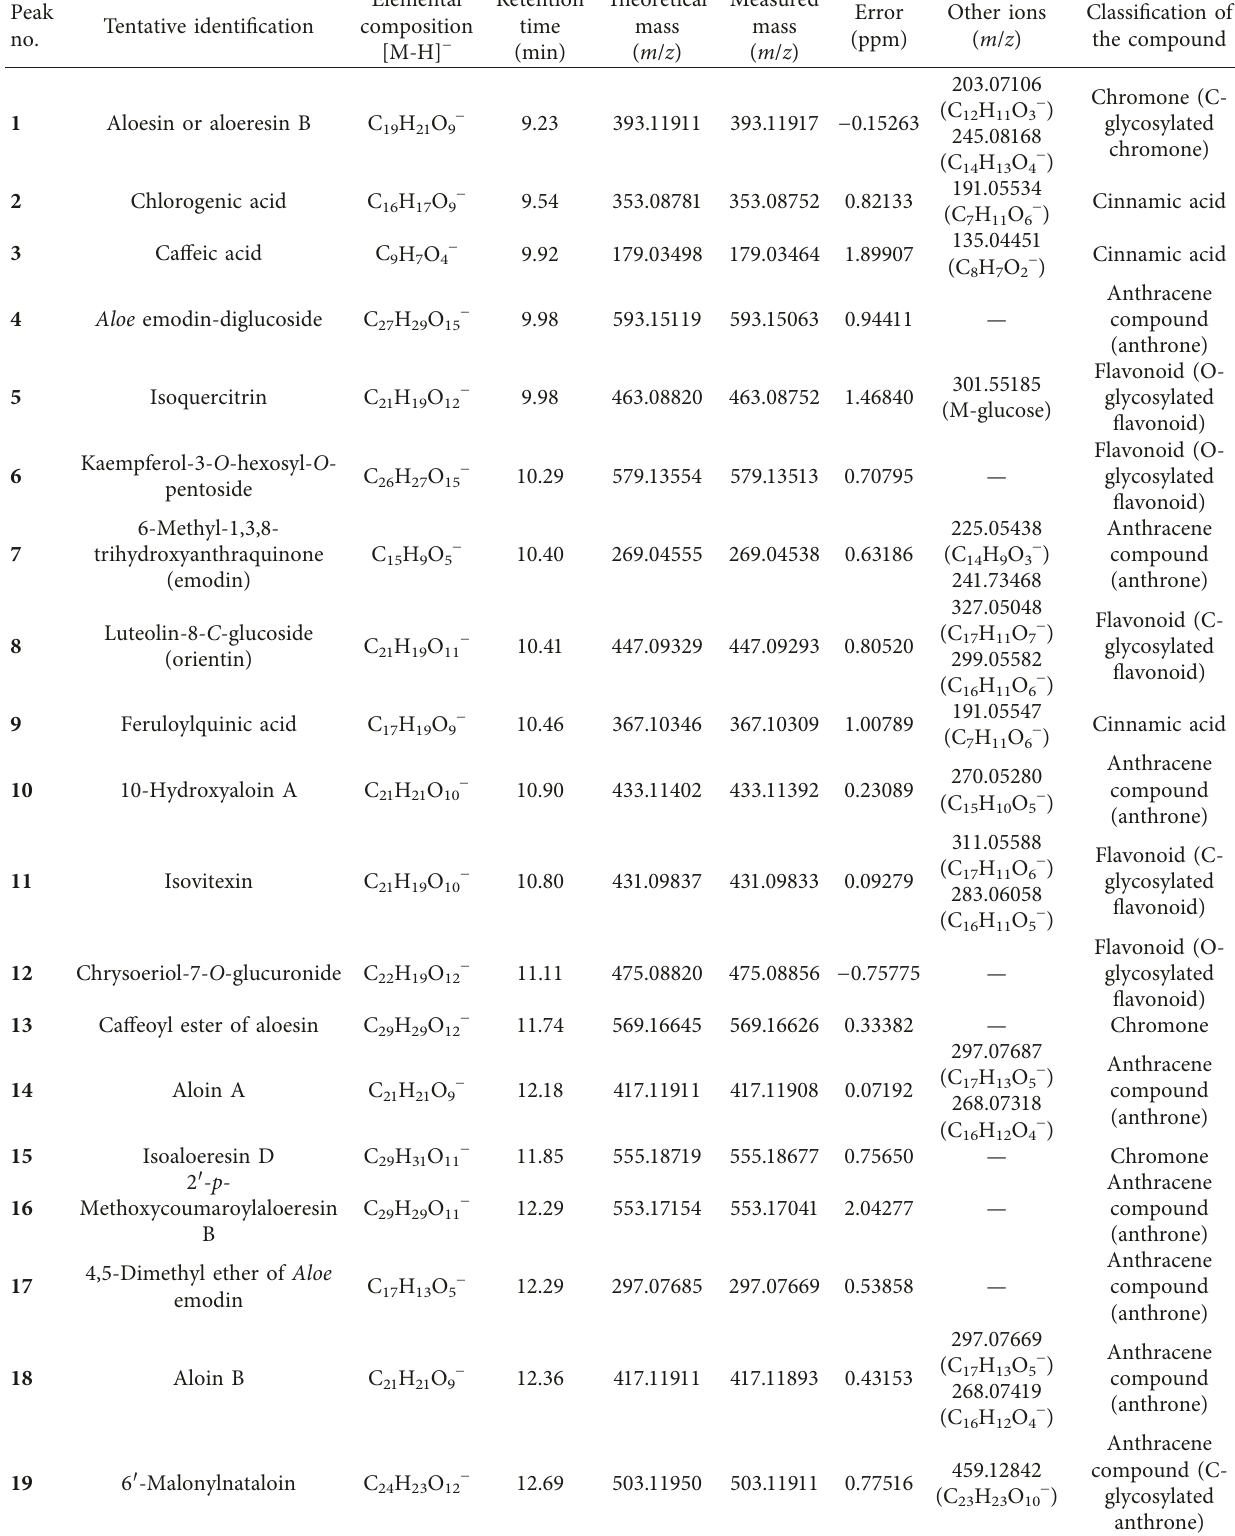
Table 1: Tentative identification of phenolic compounds in peel, flower, gel, and root of A. vera from Tarapaca Region detected by UHPLC-